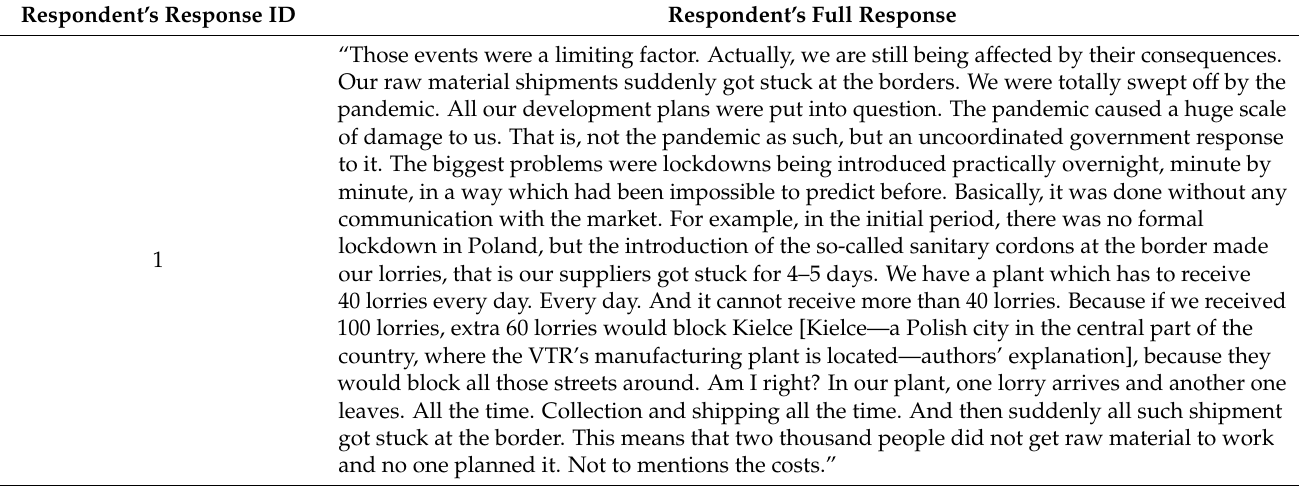
Table A2. List of selected full responses of the